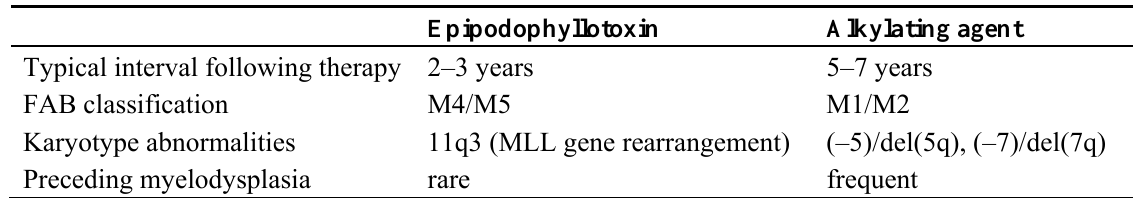
Table 1. Characteristics of secondary leukemia following epipodophyllotoxin or alkylating agent